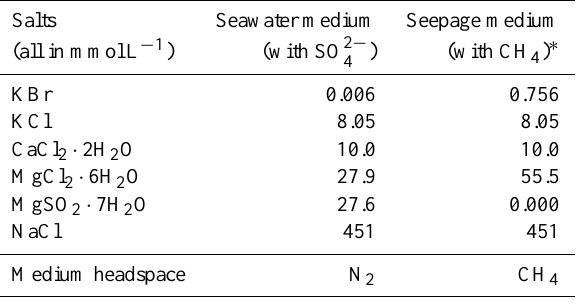
Table 3. Salt concentrations of the two different media used in the SLOT system. Seawater medium with sulfate was delivered from the top, whereas the seepage medium with methane and without sulfate was delivered from the bottom. In the last line, the gas in the respective medium’s headspace is denoted.